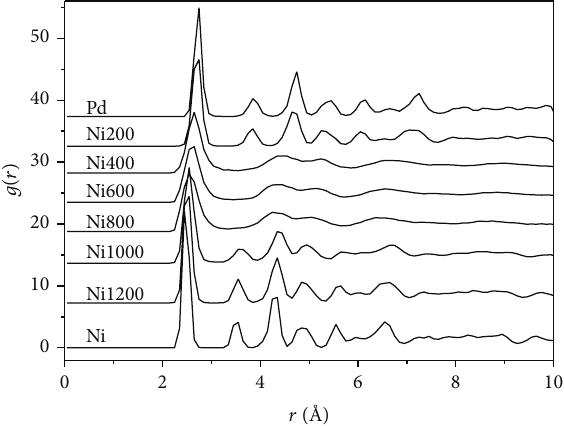
Figure 5: Radial distribution function (RDF) of Pd-Ni clusters at 300 K with the cooling rate of 0.8